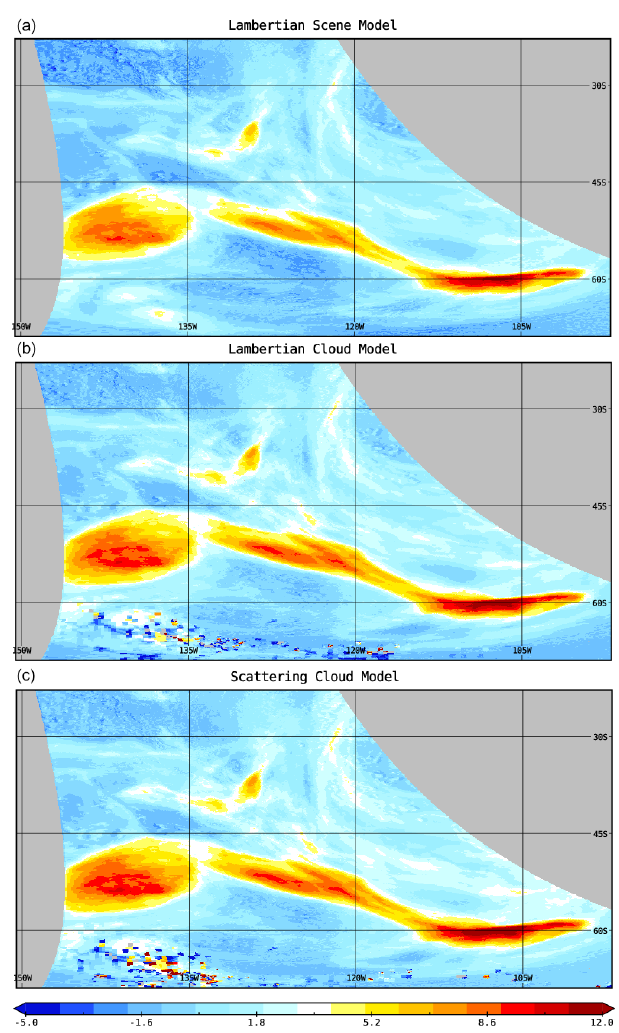
Figure 16. TROPOMI AAI of a smoke plume retrieved with the LSM (a) , LCM (b) , and LSM (c) over the South Pacific Ocean on 4 January 2020. A multitude of persistent forest fires in eastern Aus- tralia caused this large absorbing aerosol plume that was transported thousands of kilometers eastwards. The noise in the bottom of the LCM and SCM plots is caused by albedo artifacts due to melting and moving ice. There is hardly any discernible difference in the AAI plume for the three models. For this plume, the AAI values peak at 12.2 (LSM), 13.9 (LCM), and 14.3 (SCM).